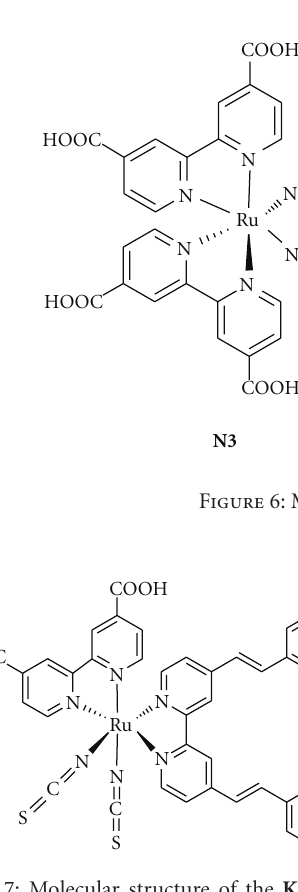
Figure 7: Molecular structure of the K19 sensitizer (taken from [23]).